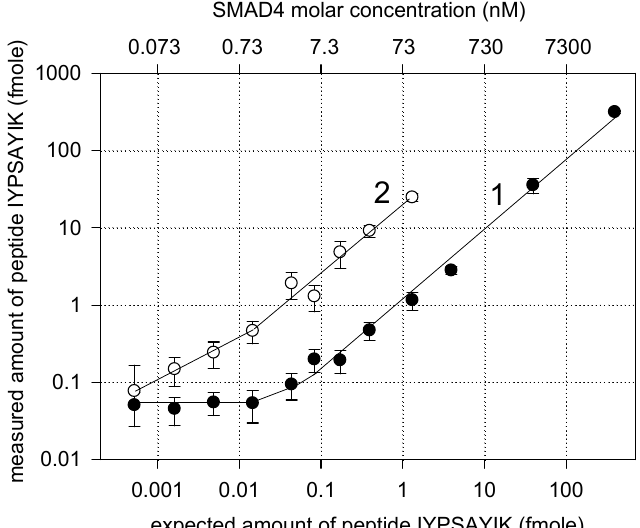
Figure 3. Dependence of the amount of peptide IYPSAYIK measured by SRM on its expected amount. Curve 1: SRM analysis of samples directly derived from plasma spiked with SMAD4; curve 2: SRM analysis of samples derived from plasma with the aptamer-based enrichment of the SMAD4 protein. The expected amount of peptide IYPSAYIK is calculated for samples derived directly from plasma. The upper axis shows the SMAD4 concentration in plasma. The mean values and corresponding standard deviations from three measurements are shown.